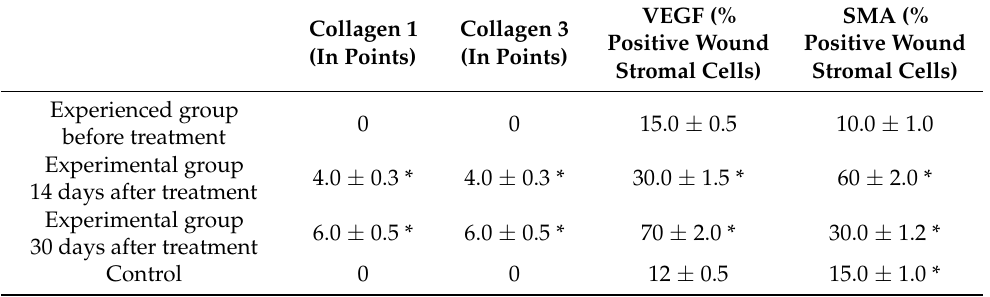
Table 2. Average values of marker expression in wound tissue before and after